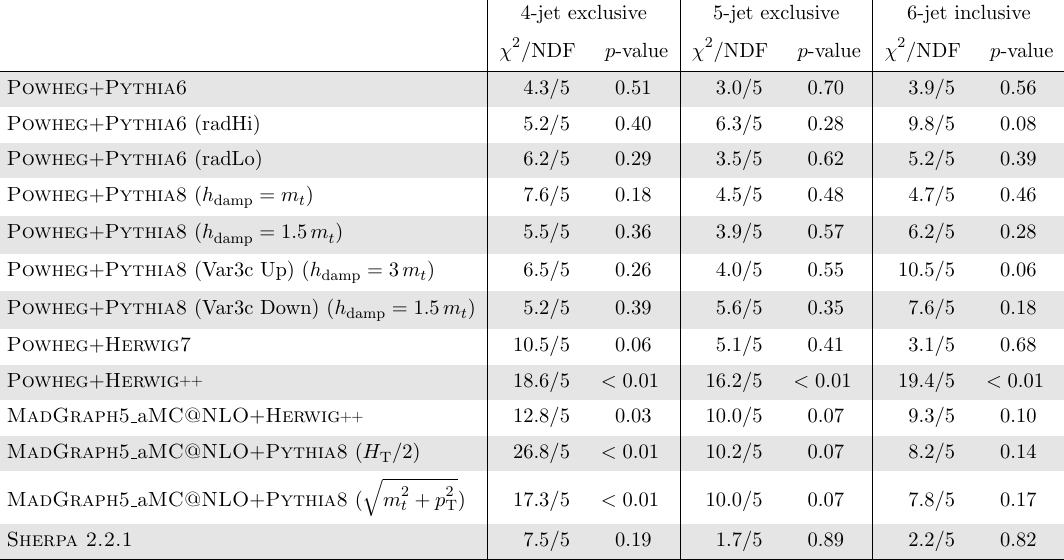
Table 6 . Comparison of the measured (cid:12)ducial phase space normalised di(cid:11)erential cross sections as a function of p t (cid:22) t and the predictions from several MC generators in di(cid:11)erent n -jet con(cid:12)gurations. T For each prediction a (cid:31) 2 and a p -value are calculated using the covariance matrix of the measured spectrum. The number of degrees of freedom (NDF) is equal to the number of bins in the distribution minus one.